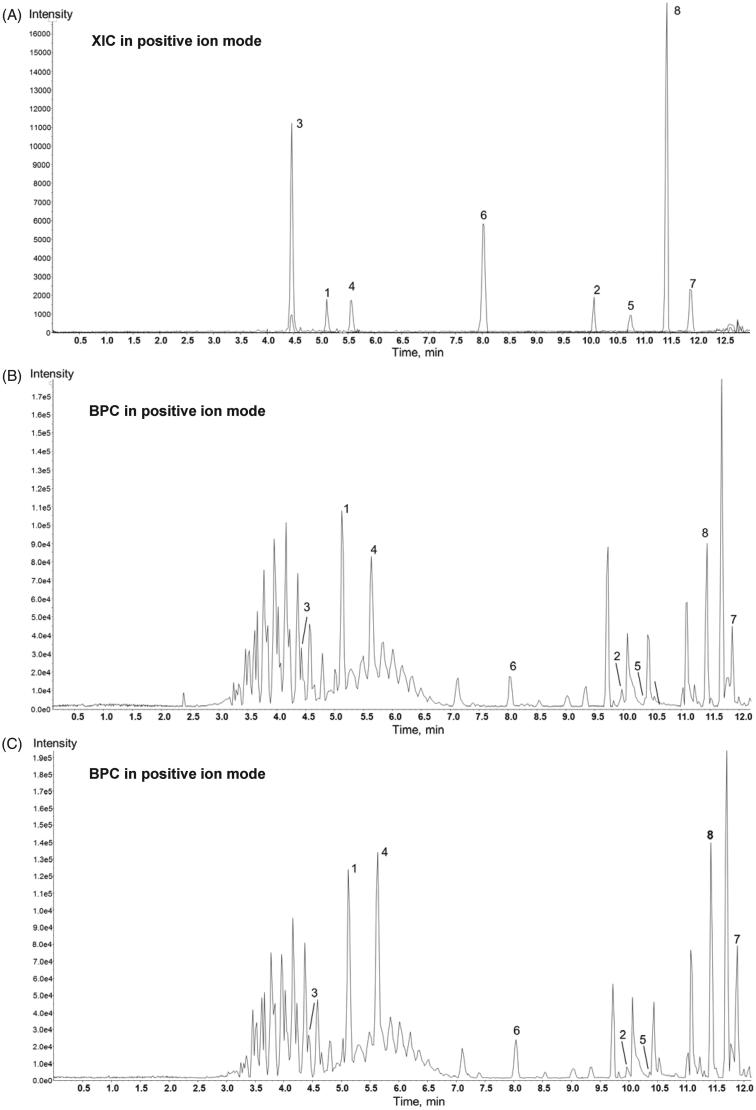
Chemical profiles of the authentic standards, WE(2-1), and AL(2-1). (A) LC-QTOF extracted ion chromatography (XIC) of 8 authentic standards; 1 narirutin, 2 narigenin, 3 rutin, 4 hesperidin, 5 hesperetin, 6 neoponcirin, 7 tangeretin, 8 nobiletin and (B) representative base peak ion chromatograms (BPC) of WE(2-1) and (C) AL(2-1).